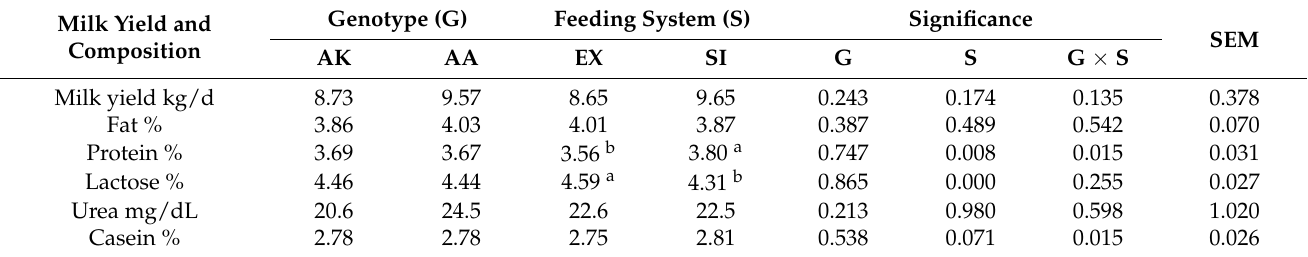
Table 1. Effects of DGAT1 K232A genotype and feeding system on mean milk yield and composition in Modicana cow. Genotype (G) Feeding System (S) Significance Milk Yield and Composition Milk yield kg/d Protein % Lactose